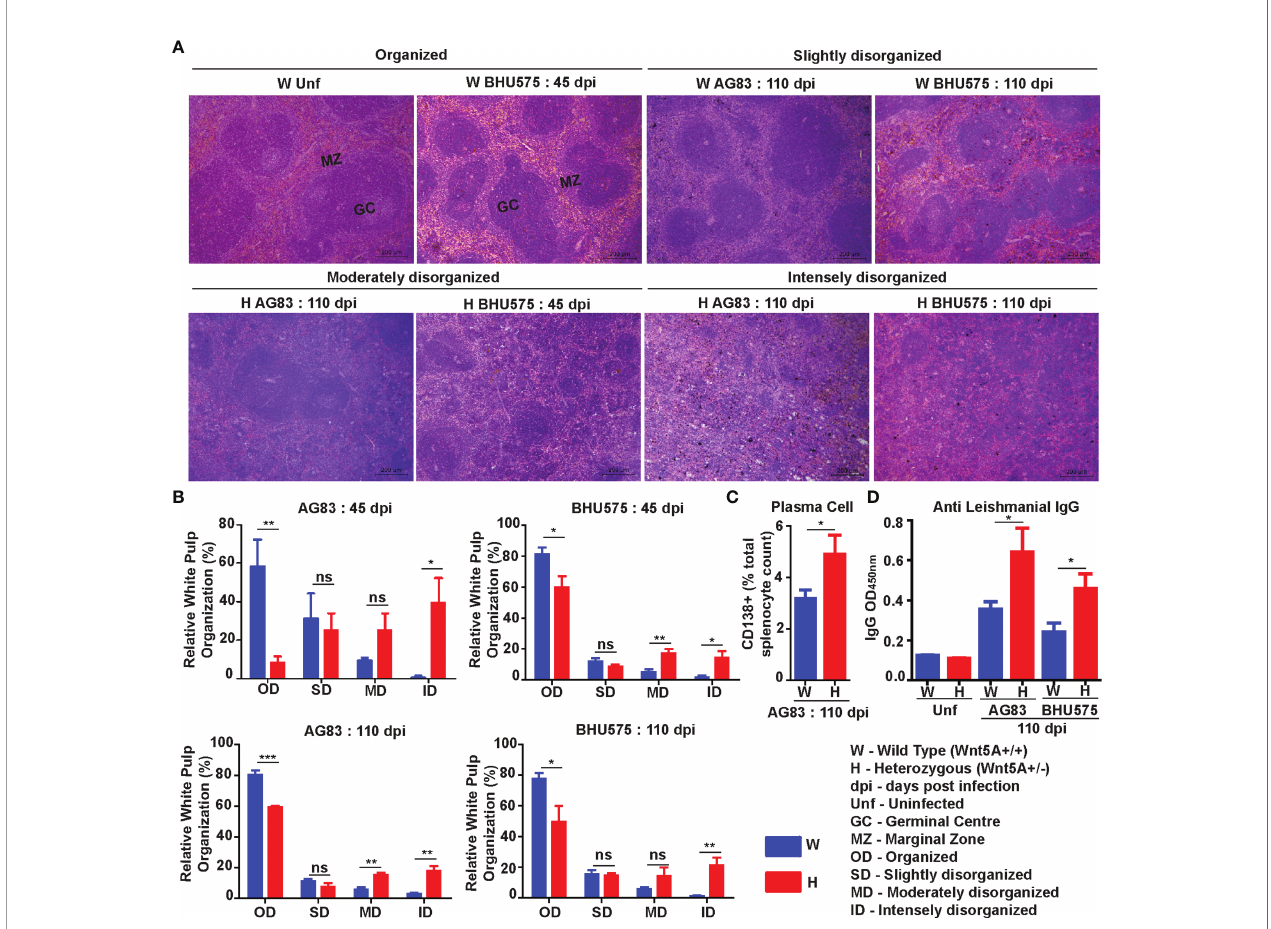
FIGURE 2 | Assessment of spleen pathology in Wnt5A+/- (H) in comparison to Wnt5A+/+ (W) mice after L. donovani infection. (A) Micrographs (under 10X objective) of representative Hematoxylin & Eosin-stained spleen sections from W and H categories, both before (unf) and after L. donovani infection (45 and 110 dpi), depicting different levels of disorganized splenic white pulp as compared to organized (explained in Materials and Methods). (B) Graphical representation of different levels of splenic white pulp disorganization in H mice as compared to W, following infection with either AG83 or BHU575, 45 and 110 dpi. (C, D) Graphical representation of higher percentage of plasma cells (C) and increased levels of IgG (D) in H as compared to W, 110 dpi. Statistical analysis was performed with the unpaired t-test. Data are presented as mean ± SEM. Signi fi cance was annotated as follows: * p ≤ 0.05, ** p ≤ 0.005, *** p ≤ 0.0005, ns, not signi fi cant, n=4 to n=6 (per